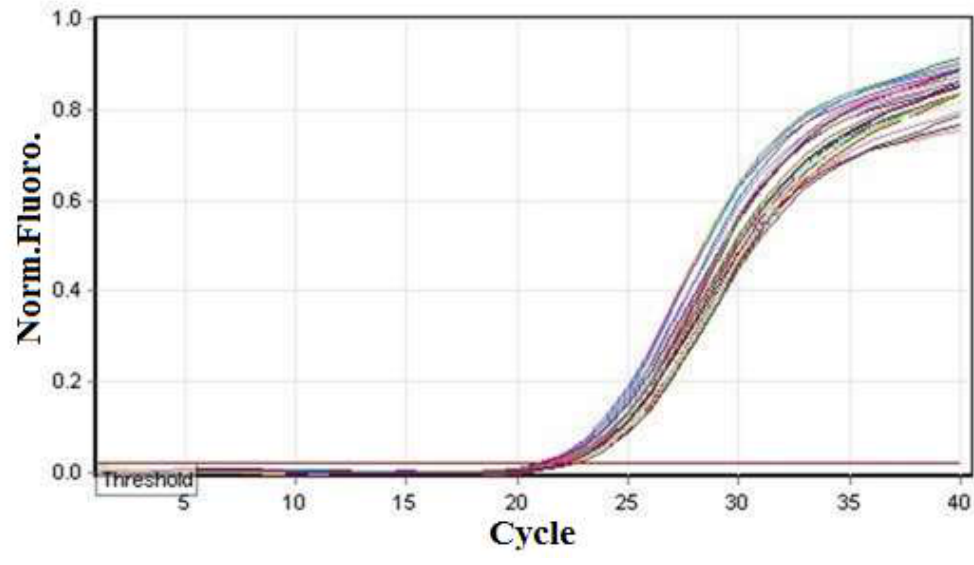
Figure 2: Amplification plots of miRNA U6 gene by RT-qPCR. A representative melt curve 122a gene for samples analyzed by RT-PCR is shown in Figure 3.